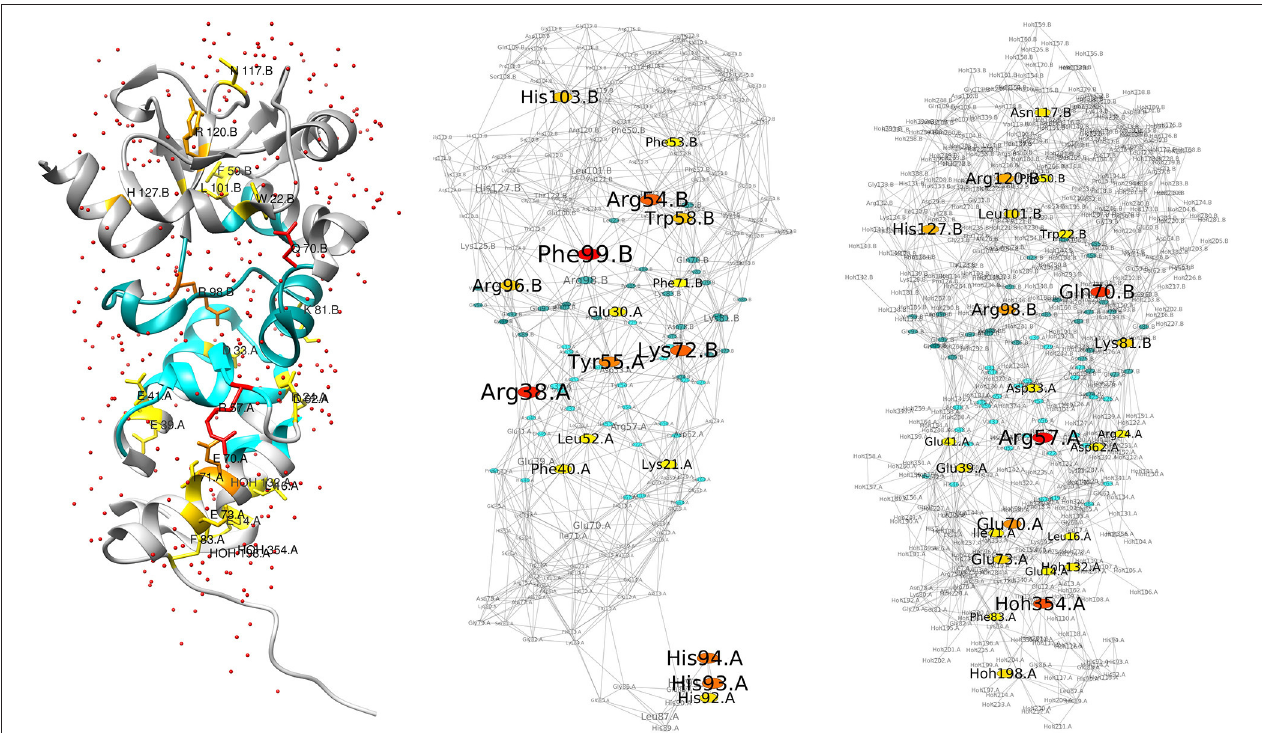
FIGURE 1 | Structure and RINs of the colicin E2 DNase-Im2 complex. For all three images, the residues at the interface between the two chains (see section 2) are colored in blue, and central residues are colored in a gradient from yellow (Z-score ≥ 2) to red (Z-score ≥ 4). (Left) Cartoon representation of the E2/Im2 complex (PDB ID: 3U43), with chain B (E2) located at the top and chain A (Im2) at the bottom; E2 is depicted in a darker shade while Im2 is lighter. Water molecules are shown as small red spheres. Central residues are drawn in stick representation; the depicted central residues are the additional ones that are highlighted in the right-hand network. (Middle) Residue Interaction Network generated from the structure, excluding water molecules. (Right) Differential Residue Interaction Network of the “wet” vs. “dry” network (see main text), highlighting only the additional central residues (also listed in Table 1 /Union).